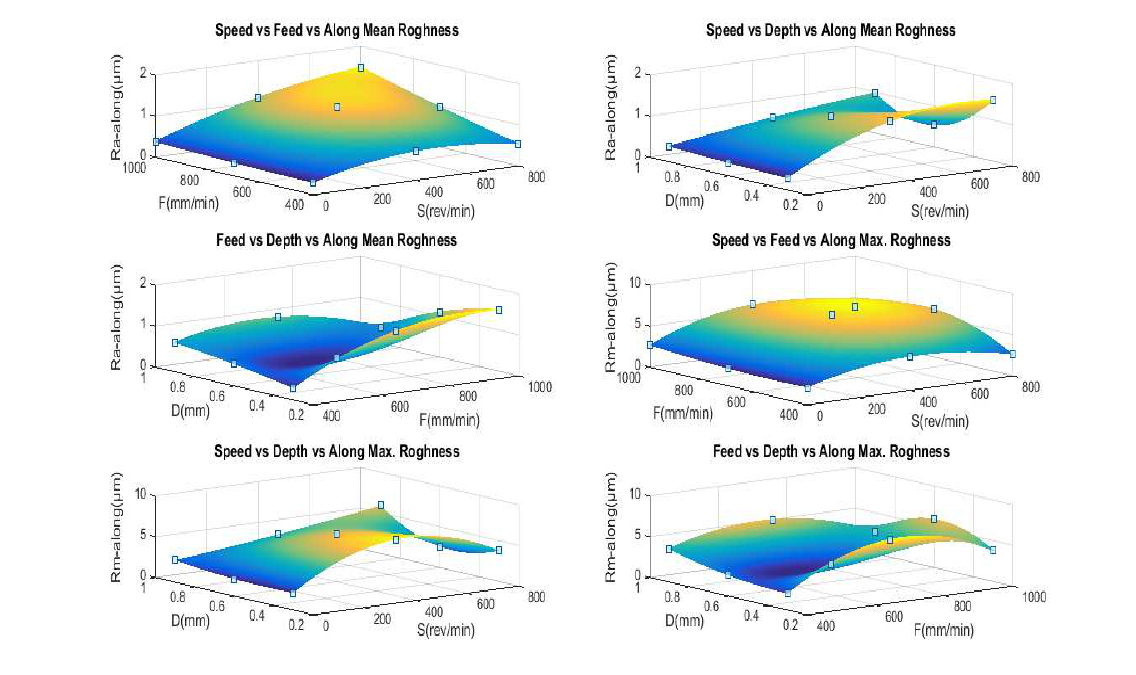
Fig. 7. The relationship of roughness (along) with respect to process variables